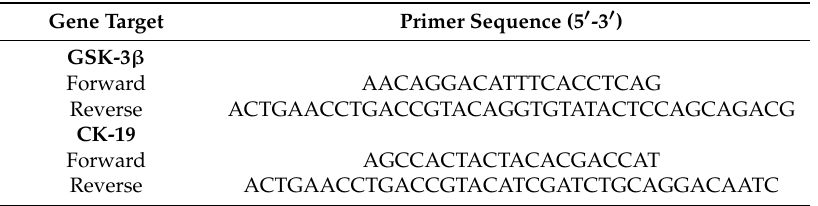
Table 2. The reaction was carried out under the following conditions: 94 ◦ C for 5 min, 96 cycles at 94 ◦ C for 15 s, 55 ◦ C for 35 s and 72 ◦ C for 20 s. The levels of the transcripts were generated using an internal standard that was simultaneously amplified with the samples, and the results are shown in two ways: levels of transcripts based on equivalent amounts of mRNA, and as a target: CK19 ratio [24]. Table 2. Primer